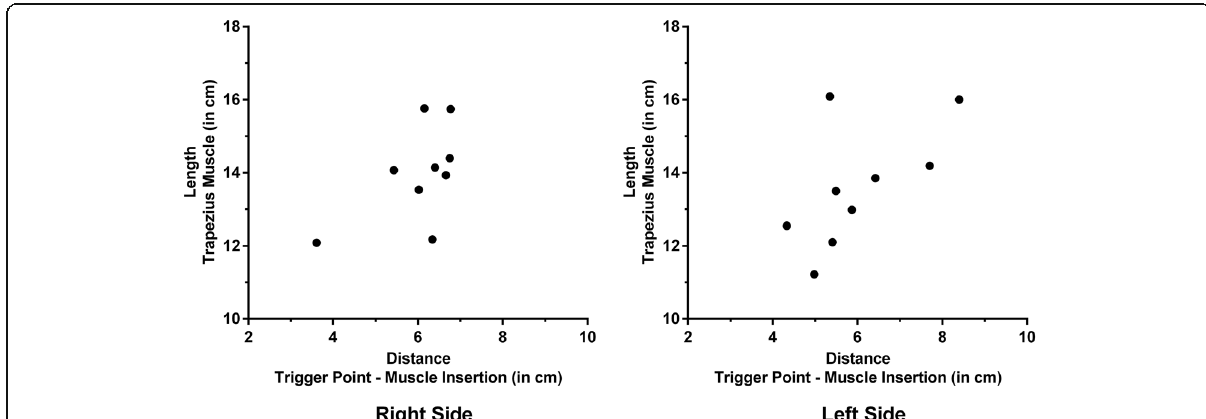
Fig. 3 Localization of myofascial trigger points (mTrPs) within the upper trapezius muscles. The graphs intend to provide information on the localization of mTrPs within trapezius muscles by capturing the linearly measured distances between the signal alteration attributed to the mTrP and the muscle insertion of the trapezius muscle (x-axis) in relation to the entire length of the trapezius muscle (y-axis) for both sides, respectively. Measurements of T2 values of signal alterations attributed to mTrPs were achieved in nine subjects per